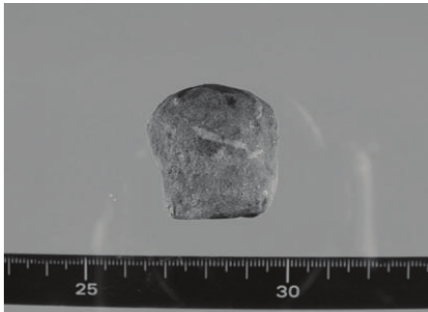
Figure 4: The extracted gallstone measuring 3.5 × 3.0 × 3.0